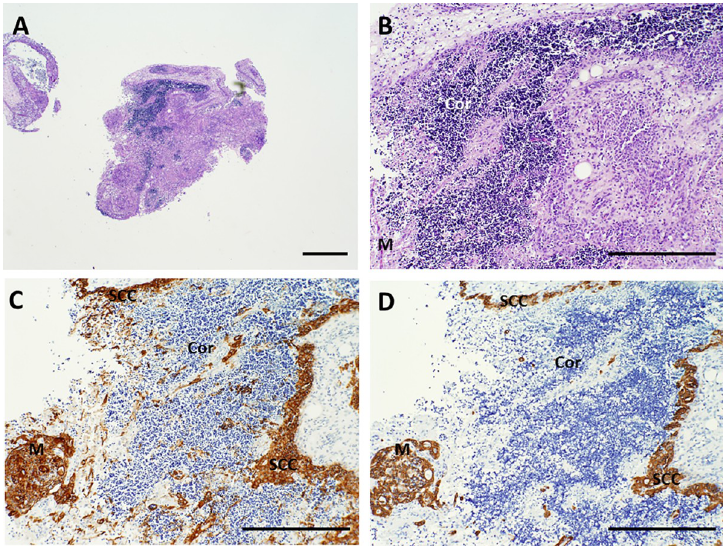
Fig 3. Architecture of cultured thymus, day 7. A, B. Hematoxylin and eosin (H&E) stain shows marked depletion of thymocytes, although some cortical areas (Cor) still contain large numbers of thymocytes with retained nuclei. Pan- cytokeratin (AE1/AE3) (C) and cytokeratin 14 (CK14) immunohistochemistry (D) show condensation of the thymic epithelium in the subcapsular cortex (SCC) and in the medulla (M). Brown color indicates a positive reaction with antibody. Bar represents 1 mm in A and 500 μ m in B–D.